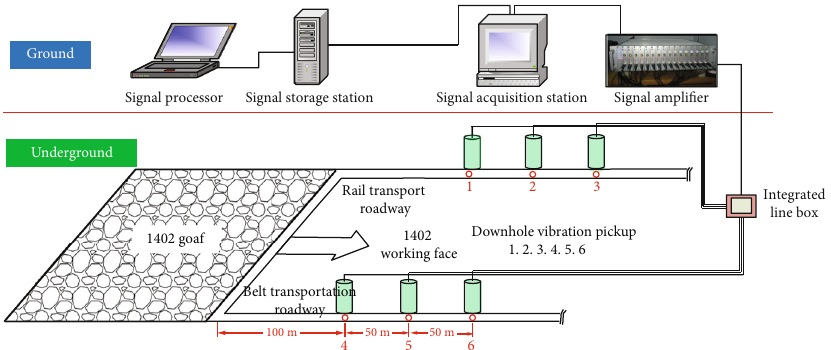
Figure 5: Working principle and schematic diagram of measuring point layout. Table 2: Optimal plan for measuring point layout.